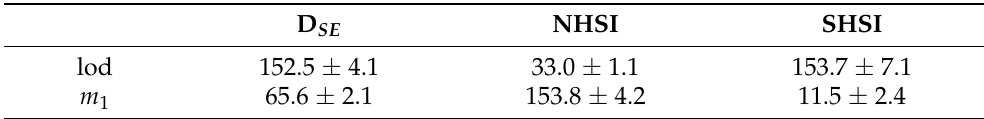
Table 1. Phase differences of the annual lines of the pairs, shown as column and line headings (in days, which in this case is very close to 1 day = 1